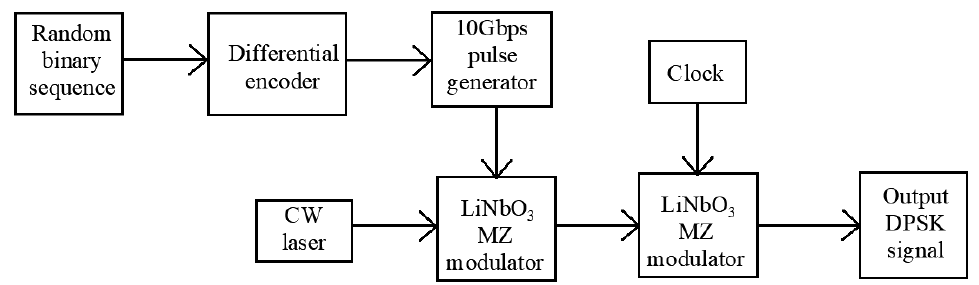
Figure 6. The generation process of RZ-DPSK optical signal. According to the value of bias voltage V bias 1 and V bias 2 , MZM usually works at three bias points: peak, zero and quadrature. Signals with different duty cycles are generated at different bias points [22,23]. This is shown in Table 1. Table 1. Generation of RZ signals with different duty cycles.